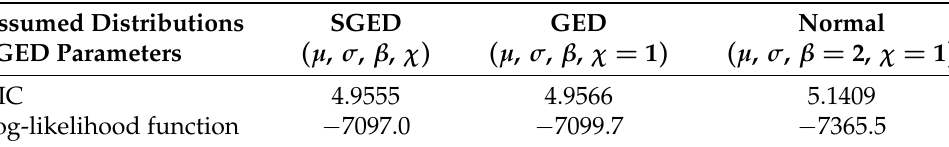
Table 5. Akaike information criterion (AIC) and log-likelihood function from three volatility models when assuming SGED, GED, and normal distribution for standardized